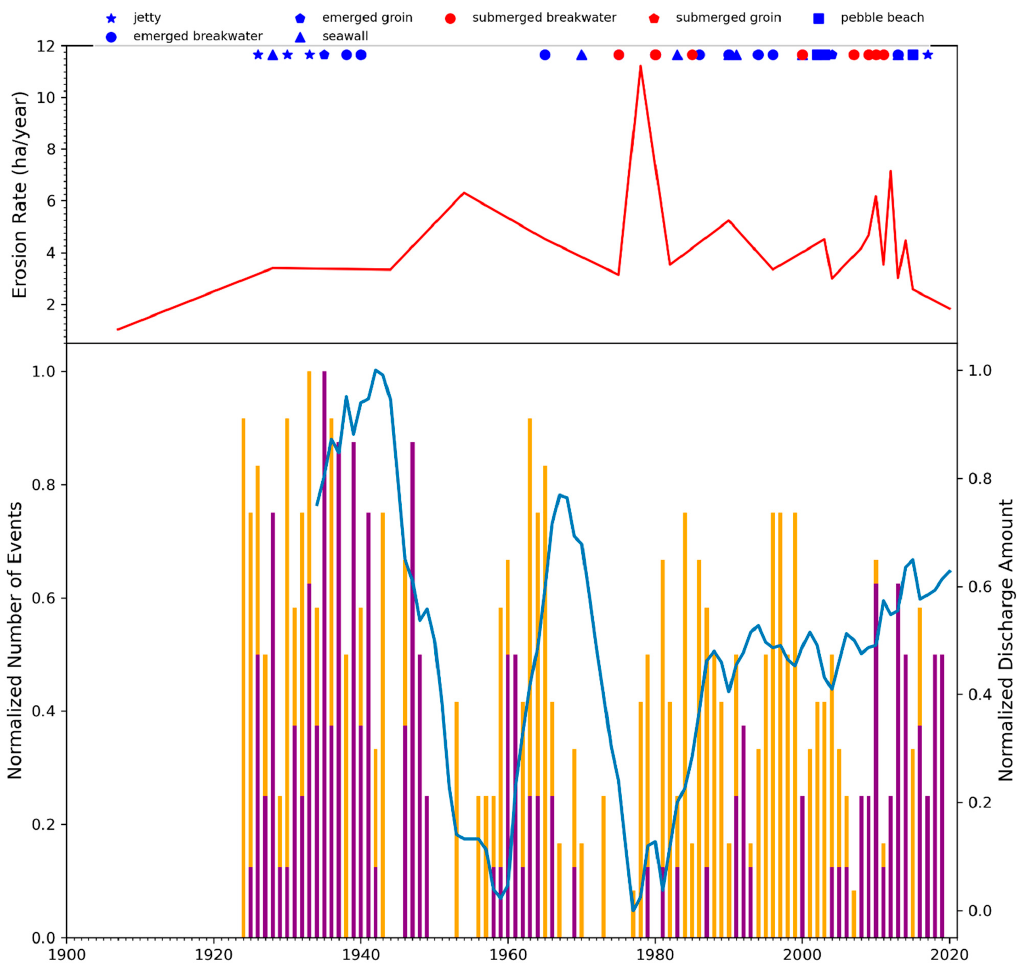
Figure 12. Relation between erosion rate of the coast (red line) and discharge of the Arno River over time. Number of flood events lower than 700 m 3 /s recorded per year (yellow bars) and the number of flood events higher than 700 m 3 /s recorded per year (purple bars). Data on number of events from Table S1. Normalized discharge amount with a 10 year mobile window of whole time series (blue line). As highlighted by Sentinel-2 analyses, the shape of the jetty at the river mouth also played a key role in the dispersion of sediments offshore and in the creation of shadow areas longshore. As documented in Figures 6 and 7, some sediments reach the northern